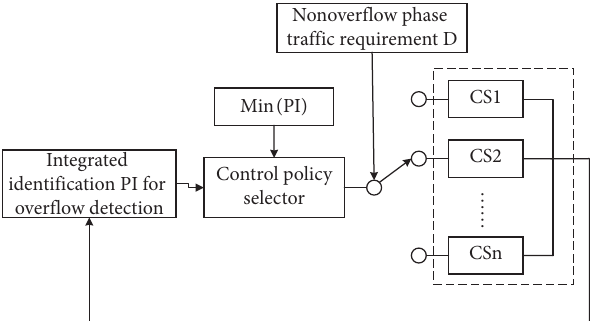
Figure 6: Overflow control strategy